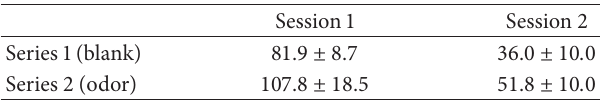
Table 6: Locomotor activity (quadrants visited, mean ± standard